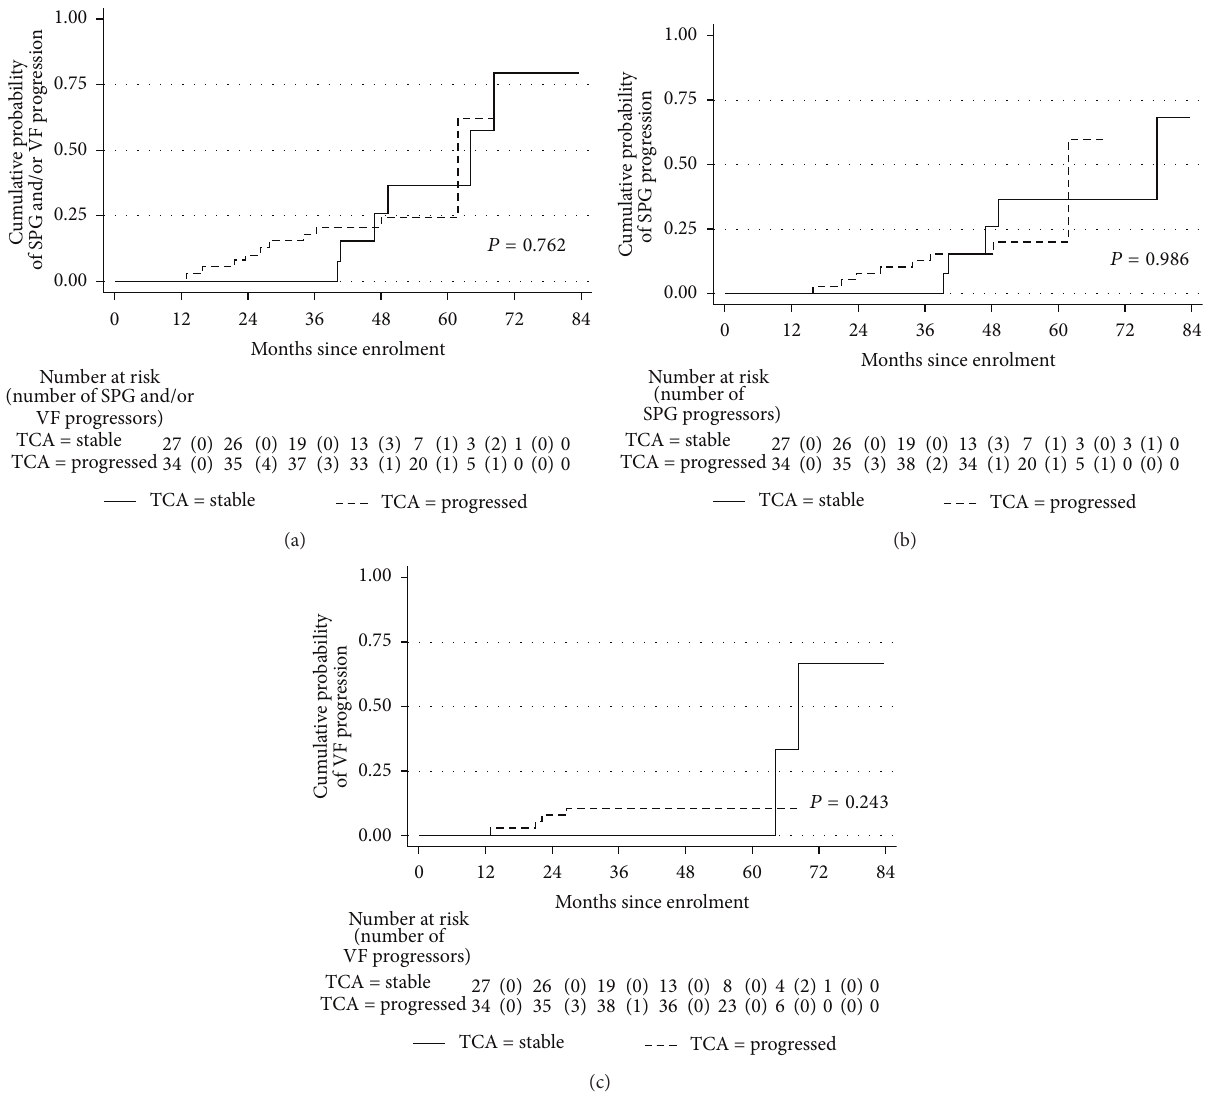
Figure 3: Kaplan-Meier curves for stereophotograph (SPG) and/or visual field (VF) progression (a), SPG only progression (b), and VF only progression (c), from recruitment, by topography change analysis (TCA) status. 𝑃 values are from log-rank test.